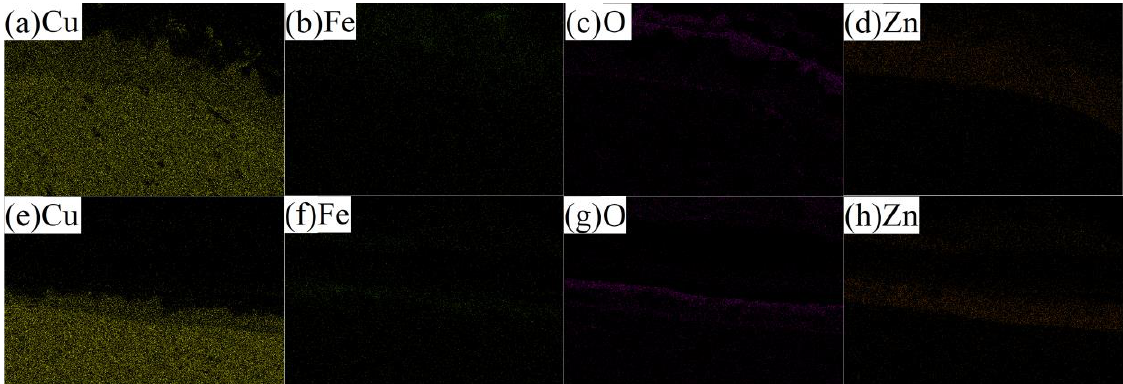
Figure 15. EDS measurements of the elements on the electrode cross-section: ( a – d ) the 176th weld; ( e – h ) the 704th weld.